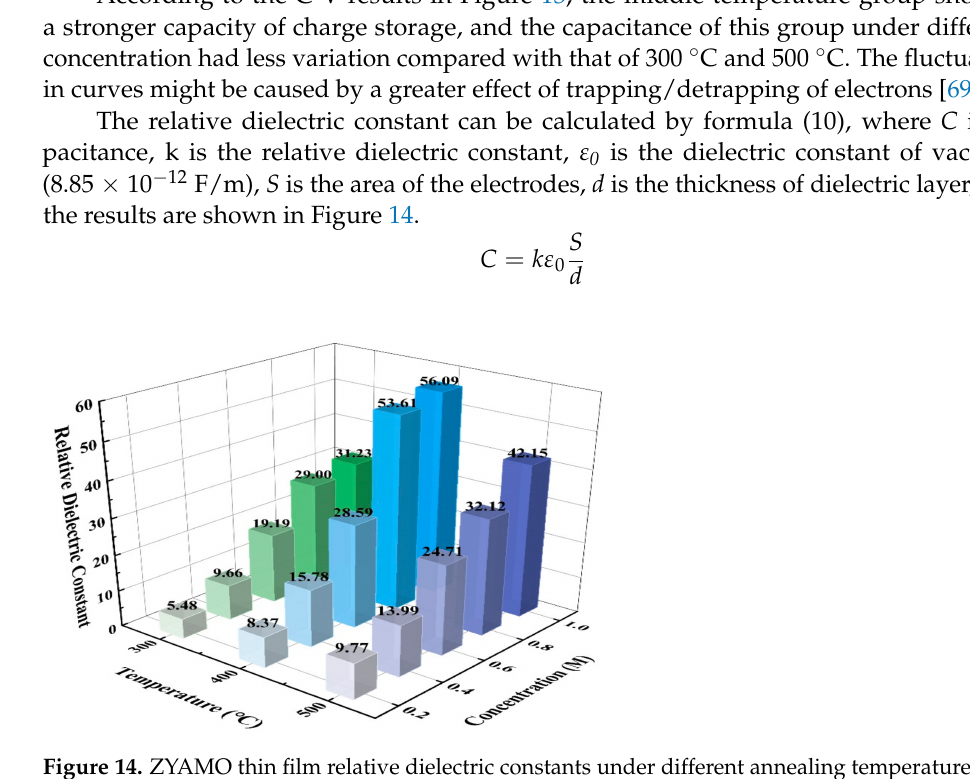
Figure 14. ZYAMO thin film relative dielectric constants under different annealing temperatures and solution